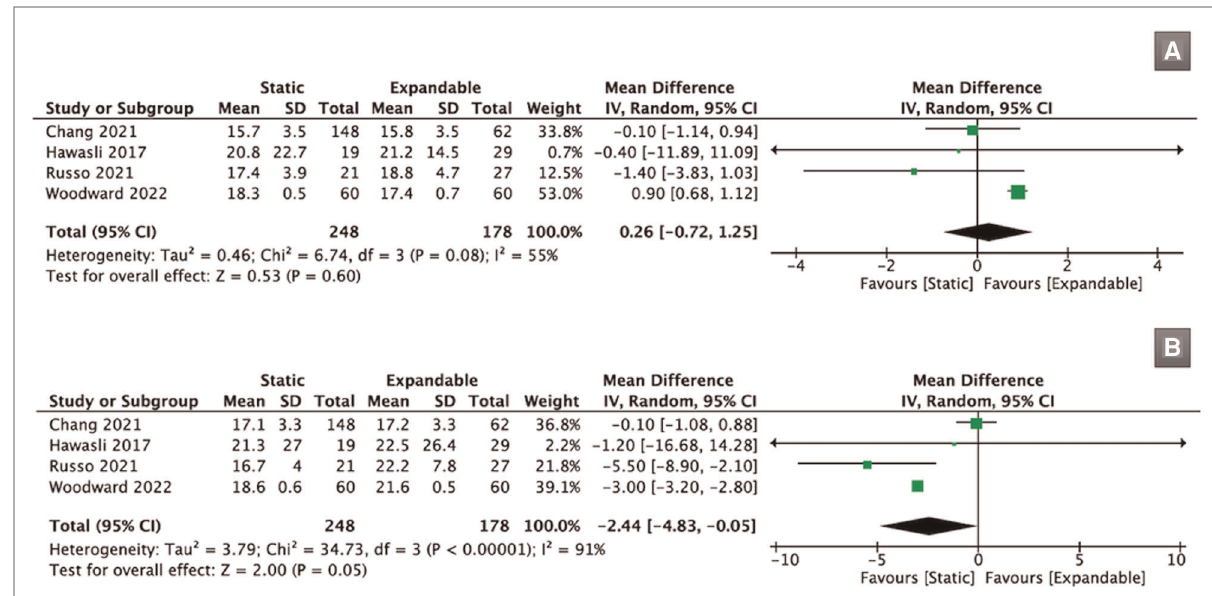
FIGURE 3 Forest plots for comparison of FH at preoperative ( A ) and fi nal follow-up ( B ) between the static and expandable groups. FH: foraminal height.